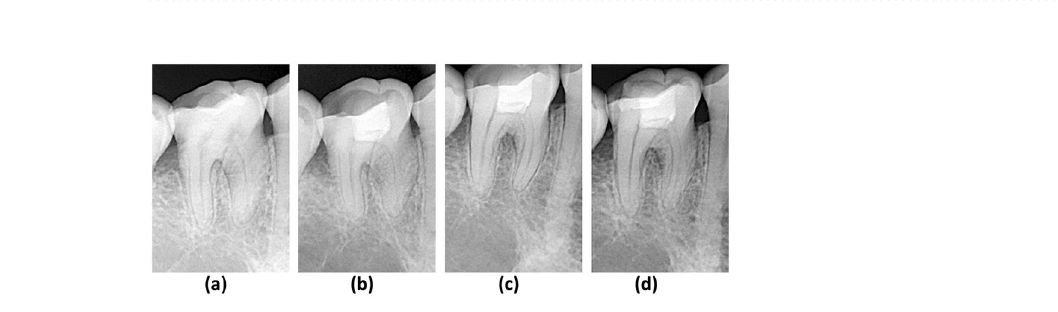
Figure 2. Radiographs of a right mandibular first molar with severe tooth wear in a 62-year-old woman. ( a ) Preoperative radiograph showing the reduced size of the pulp chamber. ( b ) 3-month follow-up. ( c ) 6-month follow-up. ( d ) 12-month follow-up.